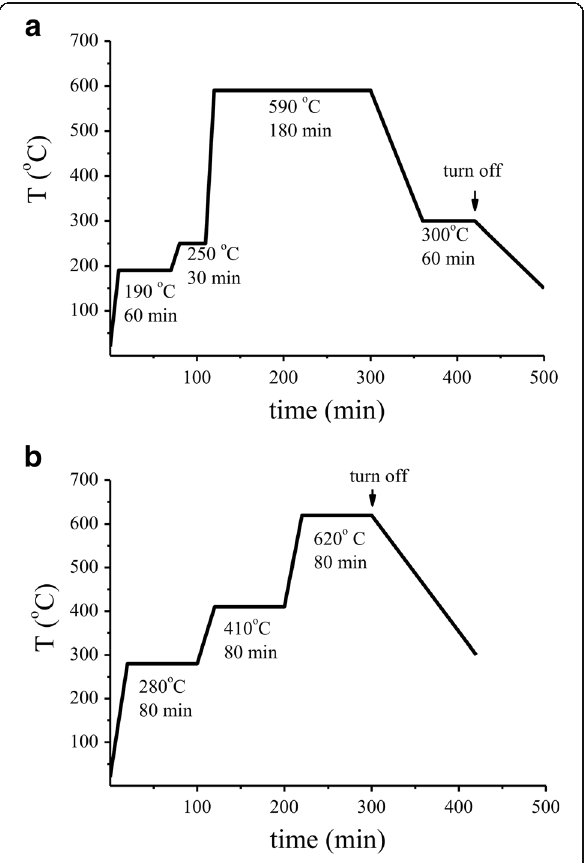
Fig. 1 Schemes of temperature heating of the sensors based on